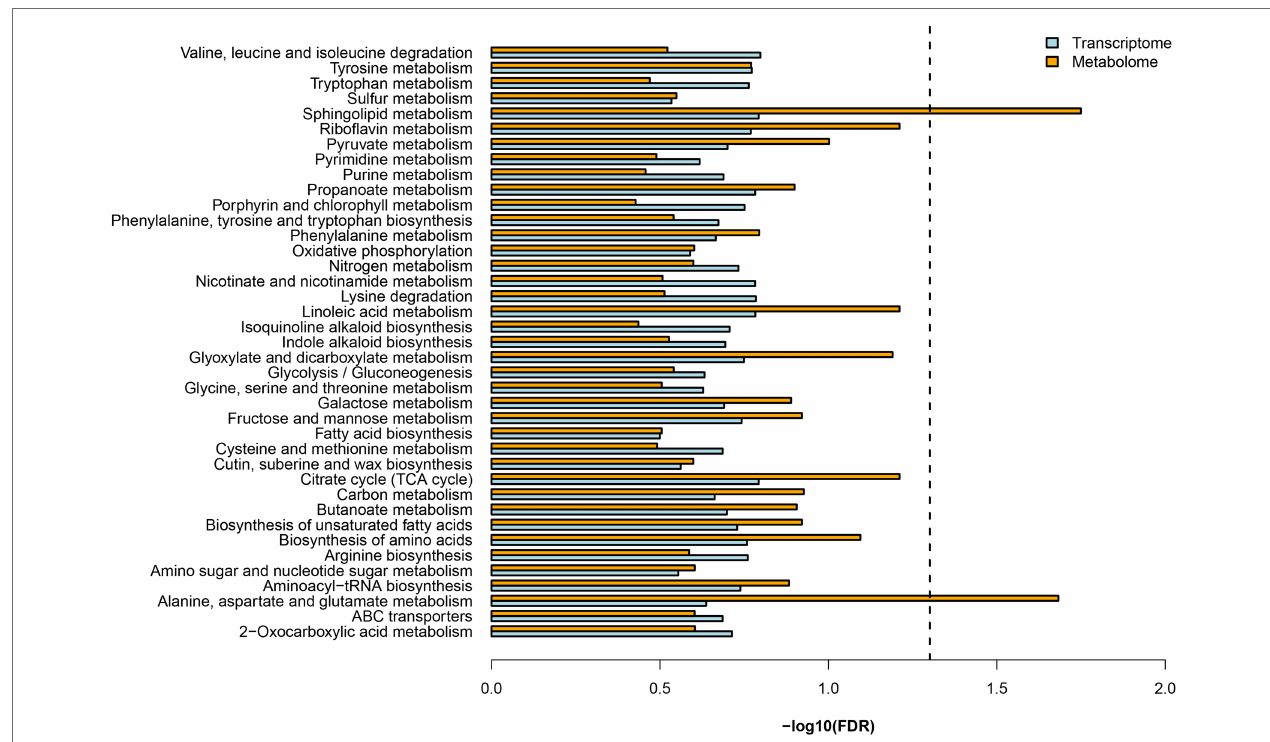
FIGURE 2 | KEGG enrichment analysis of differentially expressed gene (DEGs) and differentially expressed metabolites.